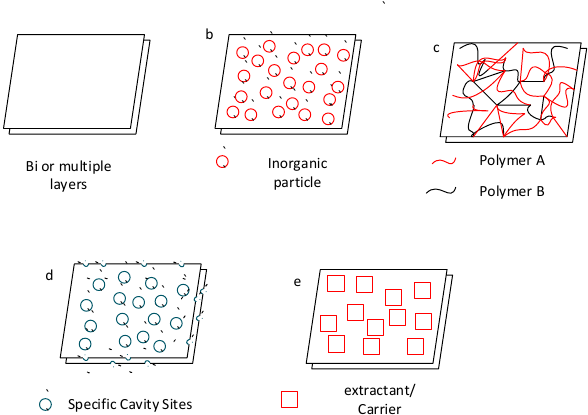
Figure 19. Natural composite membrane structures: ( a ) TF composites, ( b ) mixed matrix, ( c ) blends ( d ) molecular imprinting, and ( e ) polymer inclusion.